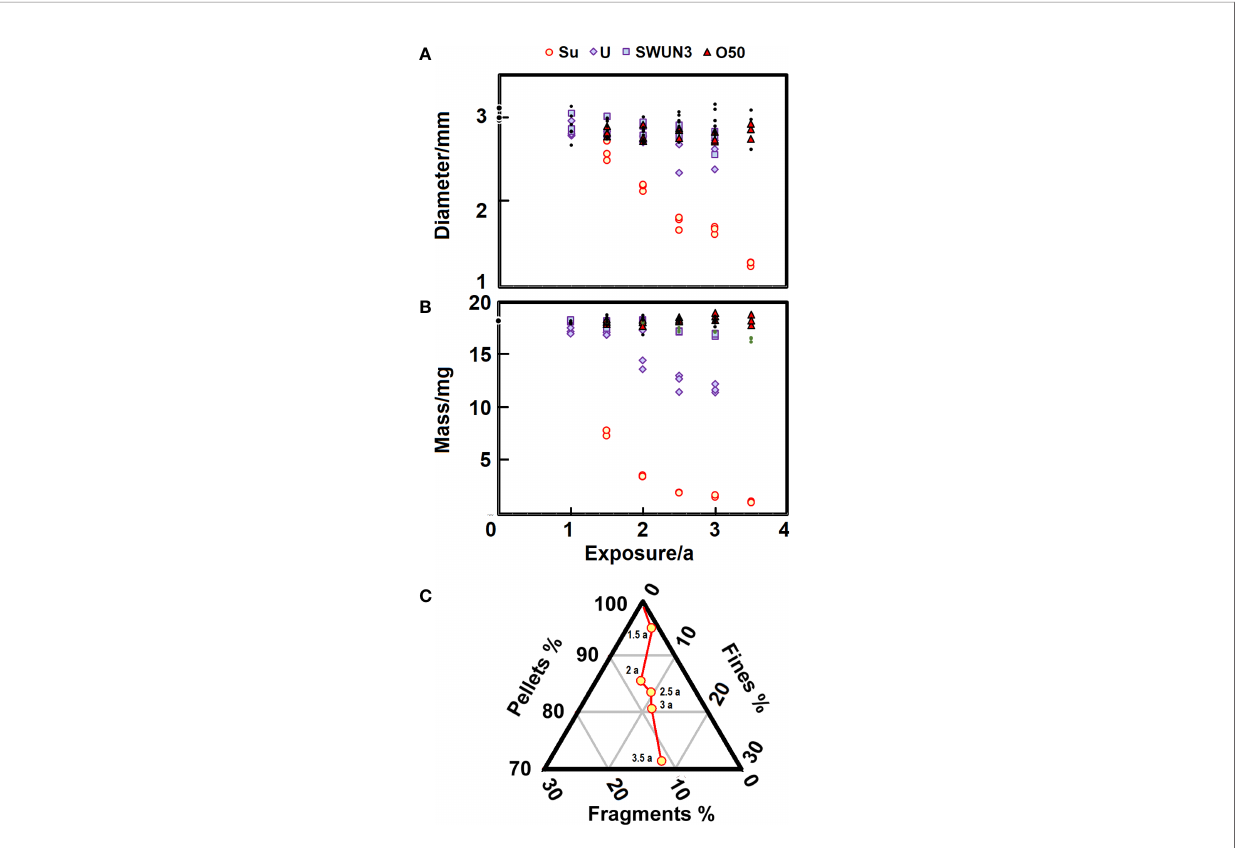
FIGURE 2 | (A) Change in diameter of particles under various types of exposure. The black dots include exposures POM_SwSuNa, POM_SWSu and POM_SwNa, which show no statistically signi fi cant change. (B) Mass loss from particles under various types of exposure. The black dots include exposures POM_SWSu and POM_SwNa, although in this fi gure POM_SwSuNa are shown as dots of a lighter shade (green dots). (C) The fraction of particles in three size ranges as they are exposed up to 3.5